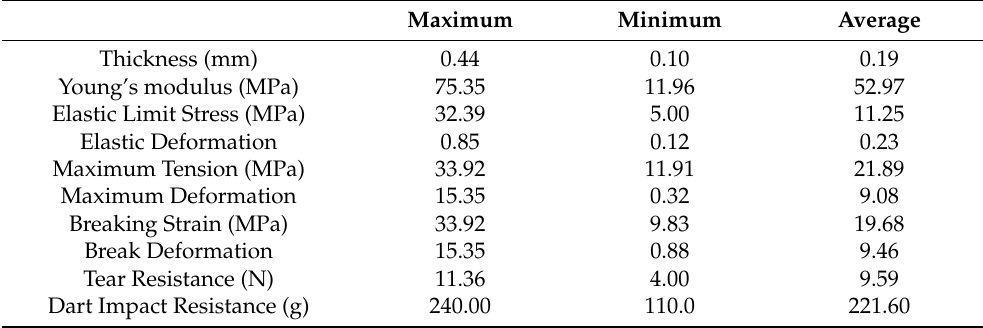
Table 6. Maximum, minimum and average values of the different parameters defining tensile strength according to the standard [33], tear resistance (N) and dart impact resistance of all the polymeric films studied in this